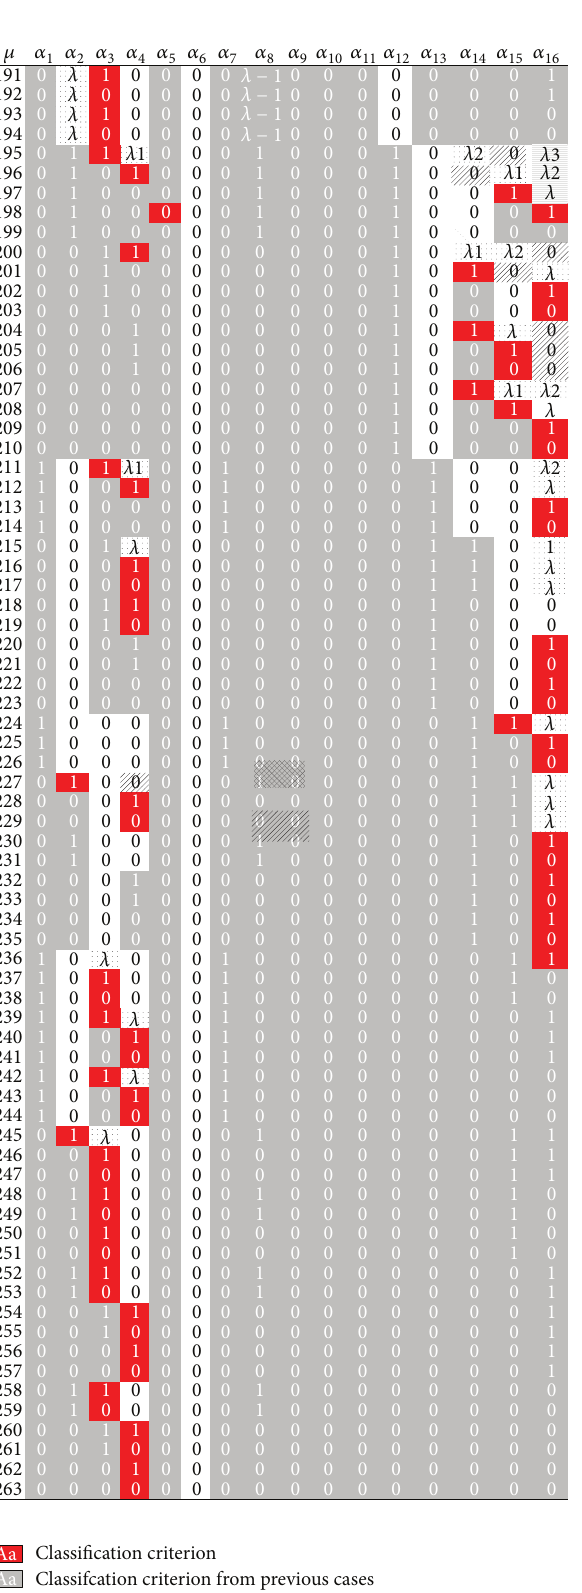
Figure 7: Case B.2.2. Second part: 𝛼 11 = 0 , 𝛼 9 = 0 , and 𝛼 5 = 0 . Classification of the QFLA of dimension